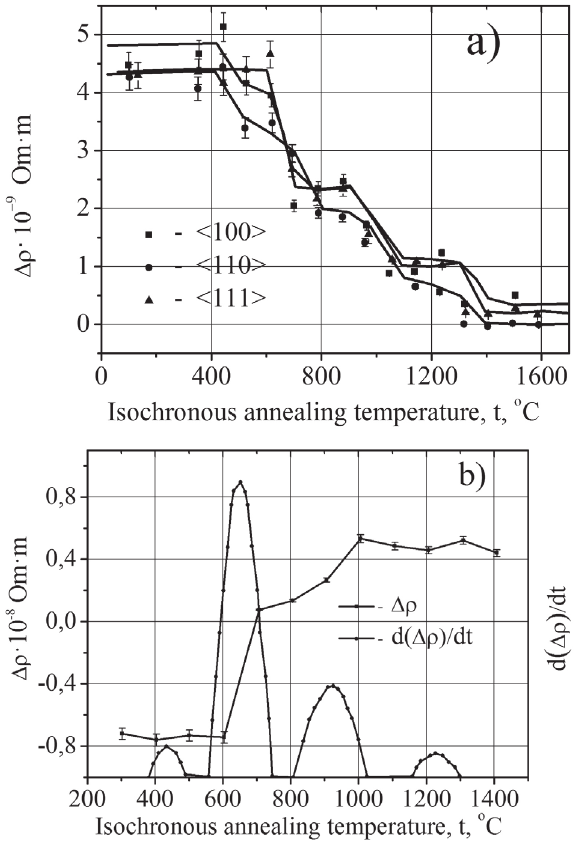
Figure 1. Recovery of the electrical resistance of the irradiated samples of molybdenum (a) and vanadium (b) during isochro- nous annealing.